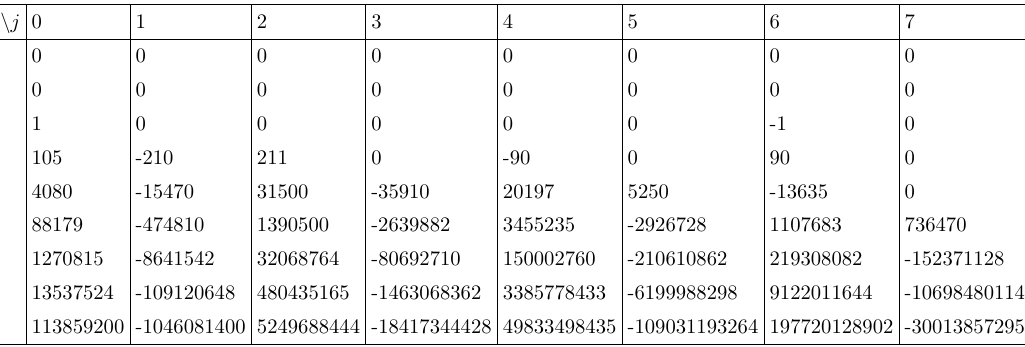
Table 80. Table of b jk coe(cid:14)cients for h SO(15)